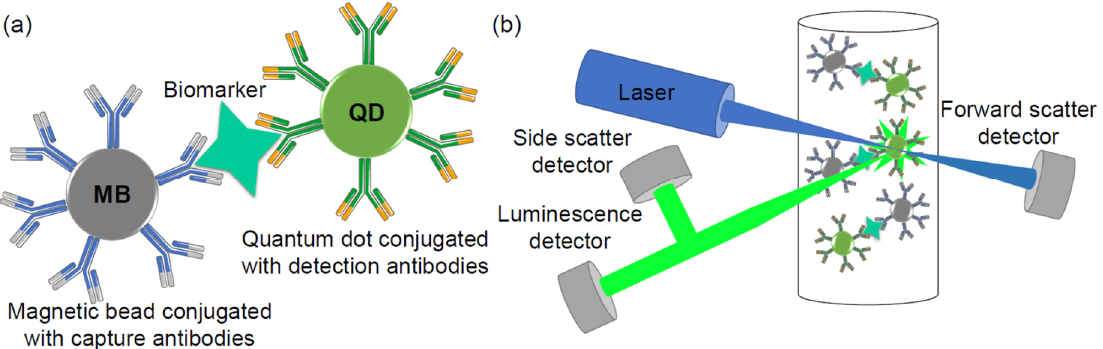
Figure 3. Schematic illustration of a magnetic bead–quantum dot (MB–QD) sandwich assay for biomarker capture and detection; ( a ) magnetic bead–biomarker–quantum dot conjugate; ( b ) simplified flow cytometer scheme.